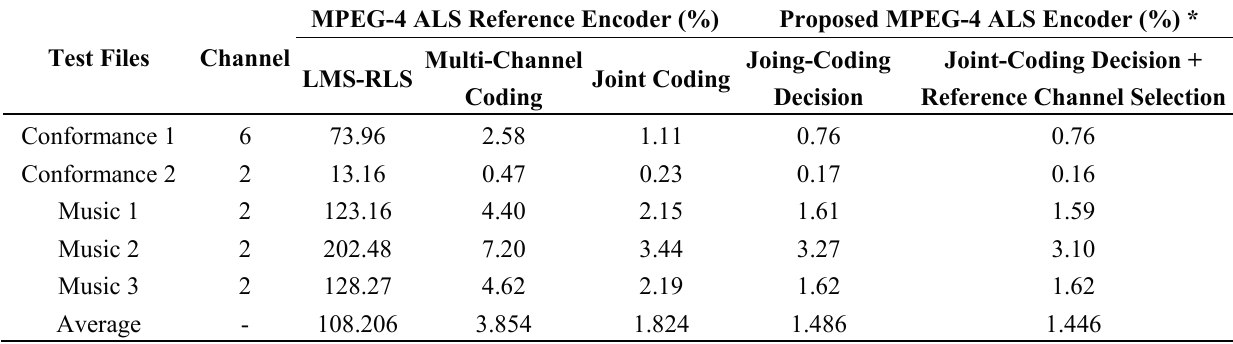
Table 2. Encoding time of the proposed MPEG-4 ALS encoder.